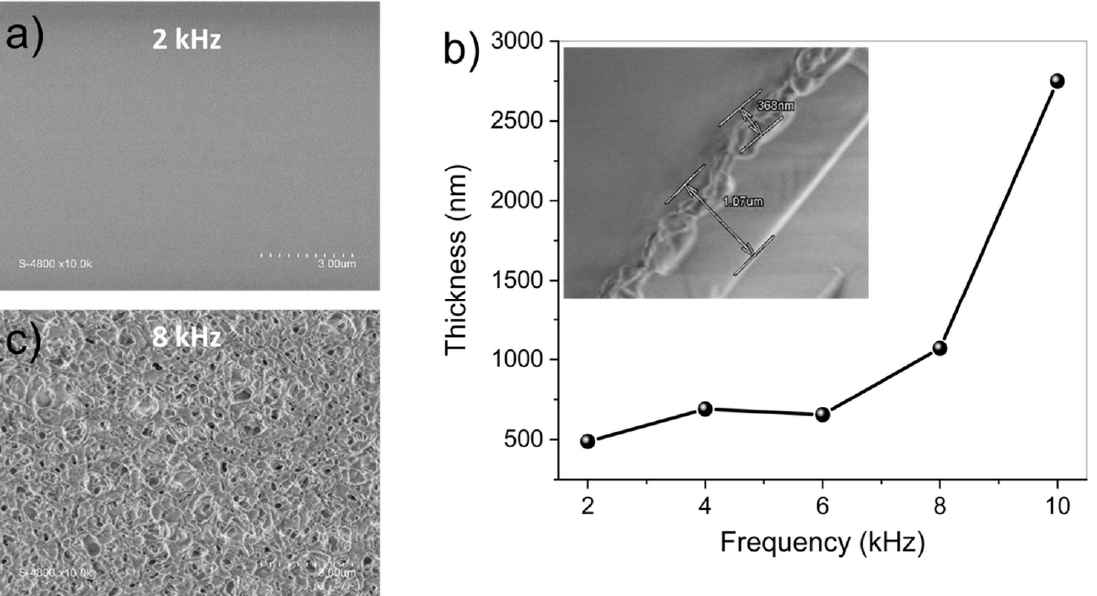
Figure 7. SEM-derived results of pp-PEG obtained films: ( a ) SEM image of a pp-PEG film obtained in atmospheric-pressure DBD at 2 kHz; ( b ) thickness variation of the obtained films with frequency with an inset showing the cross-section of the sample obtained at 8 kHz; and ( c ) SEM topography of the sample obtained at 8 kHz.